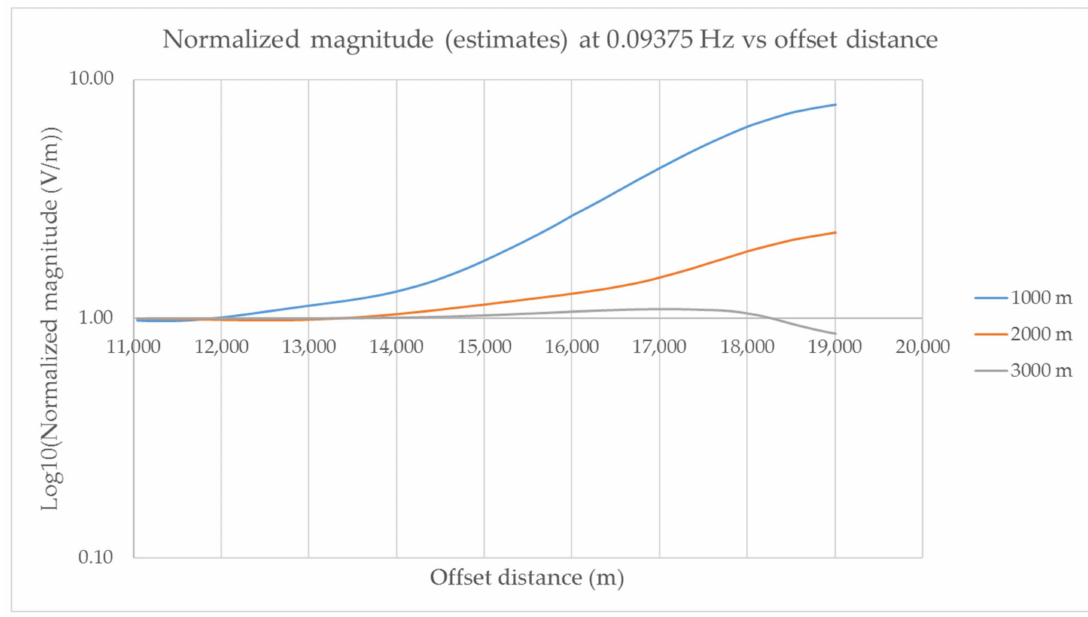
Figure 13. Normalized MVO responses for transmission frequency of 0.09375 Hz: (i) normalized MVO for a hydrocarbon depth of 1000 m (blue); (ii) normalized MVO for a hydrocarbon depth of 2000 m (reddish-yellow); (iii) normalized MVO for a hydrocarbon depth of 3000 m (grey).